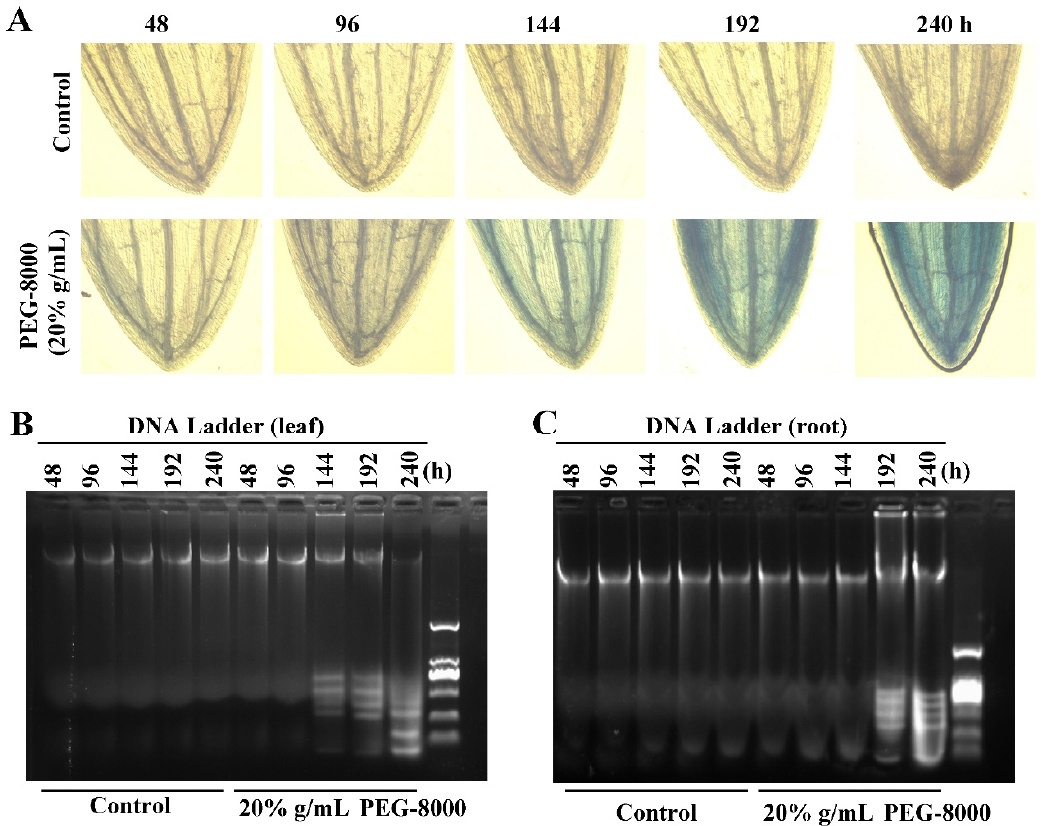
Figure 6. PCD in wheat seedlings following long-term treatment with PEG-8000. ( A ) Trypan blue staining of leaves following treatment with 20% PEG-8000 for 48, 96, 144, 192, and 240 h. ( B – C ) DNA ladder assay of PCD in the leaves and roots following long-term treatment with 20% PEG-8000, respectively. Control: treatment with water. Data represent the results of three experiments.